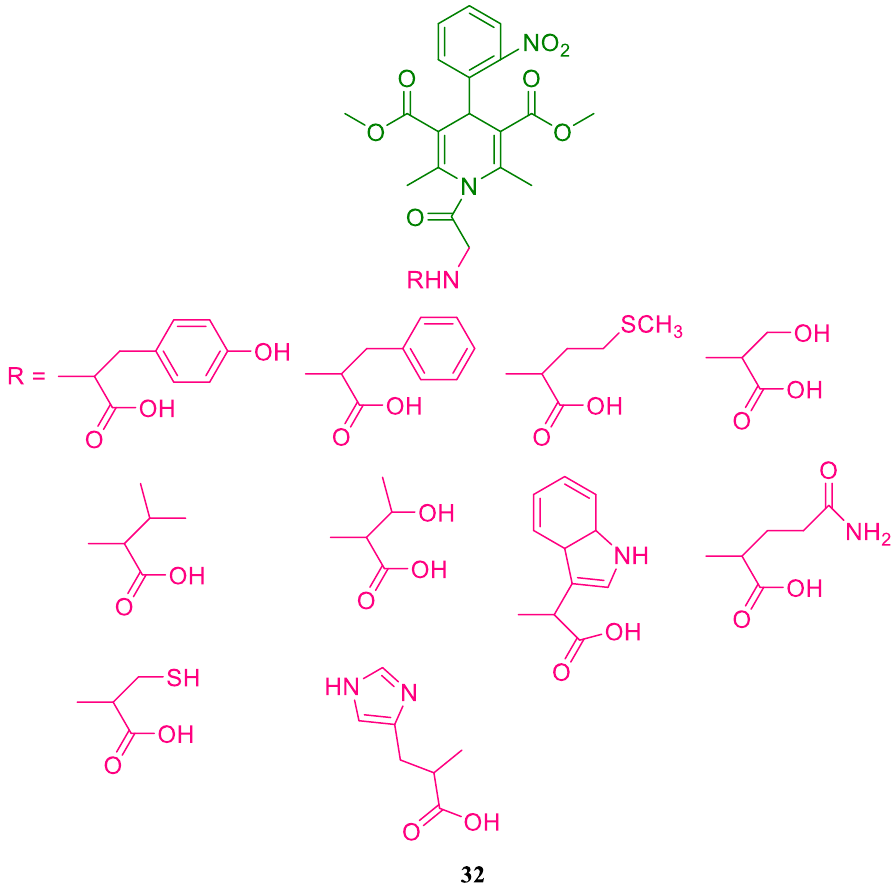
Figure 35. Amino acids conjugated to nifedipine.